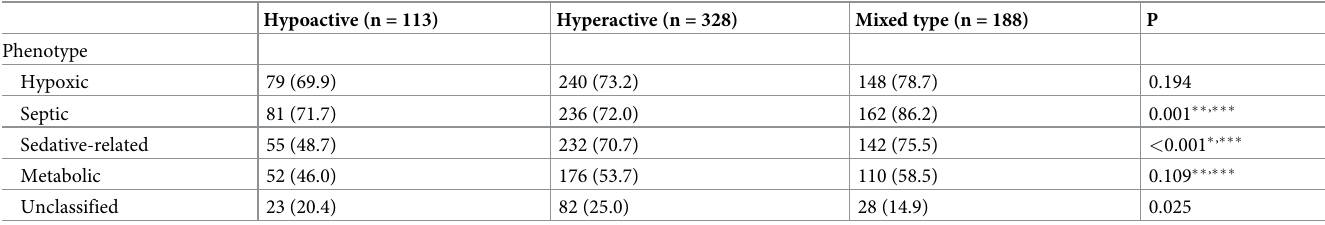
Table 5. Prevalence of delirium phenotypes according to motor subtypes of delirium.